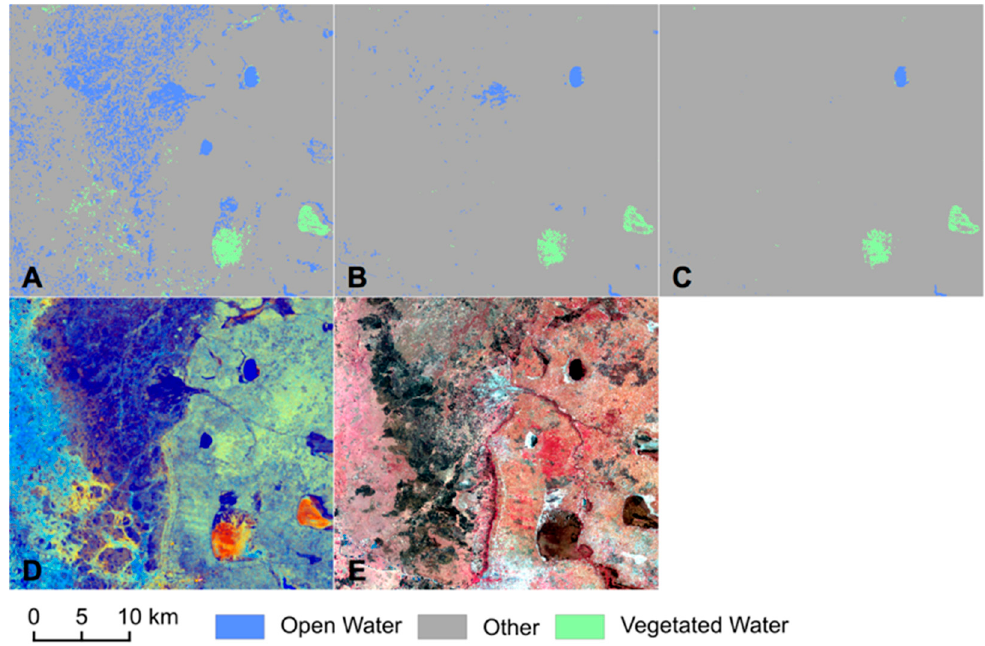
Figure 7. Progressive classification improvement following implementation of the classification certainty and dry season refinement. Example image from 2 Sept 2017 (dry season). ( A ) Pre-refinement classified image, ( B ) post-classification certainty refinement, ( C ) post-Otsu thresholding of open water mask, ( D ) input VV, VH, VV/VH Sentinel-1 image and ( E) reference NIR, R, G Sentinel-2 optical image.